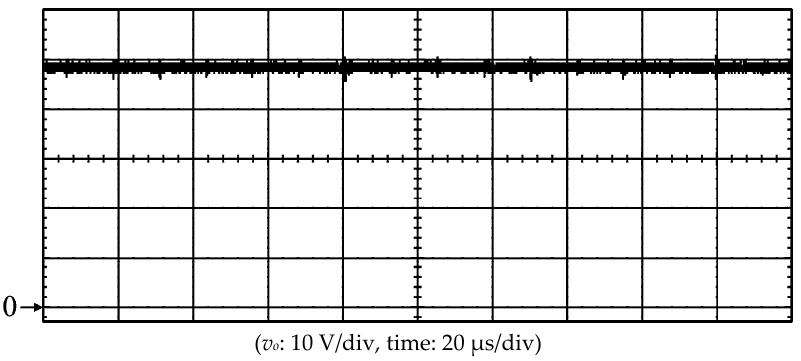
Figure 12. Switching spikes on the output voltage.